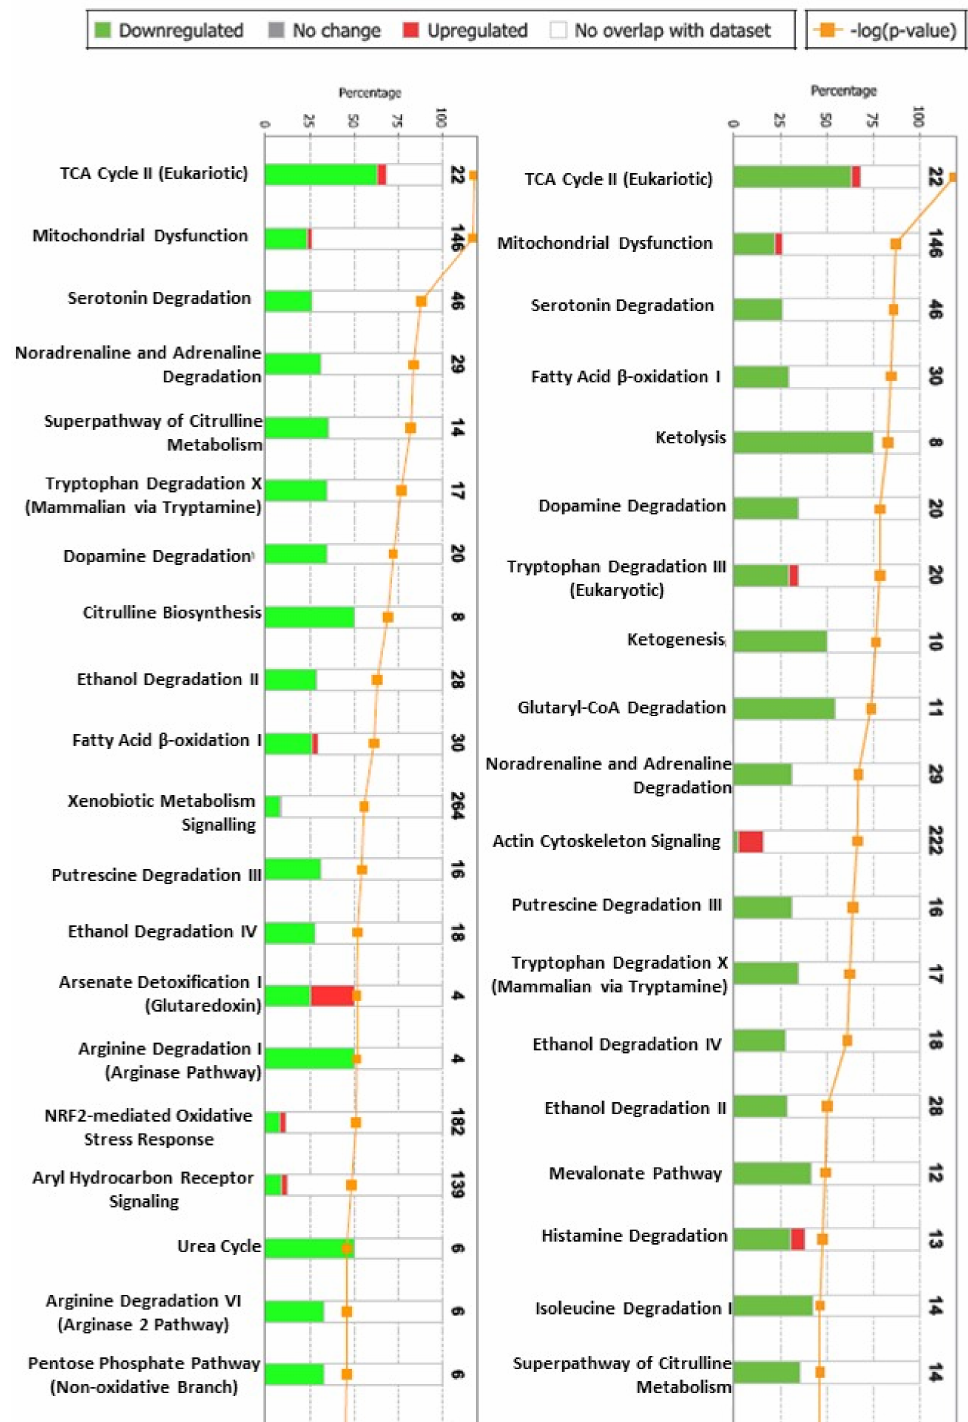
Figure 3. The alterations in the first 20 canonical pathways in allogenic grafts between post-transplant day 3 and day 6 ( left ) and between rejecting (allogeneic grafts) and non-rejecting (syngeneic grafts) at post-transplant day 6 ( right ) as revealed by the interactive pathway analysis. Downregulated pathways shown in green, upregulated pathways shown in